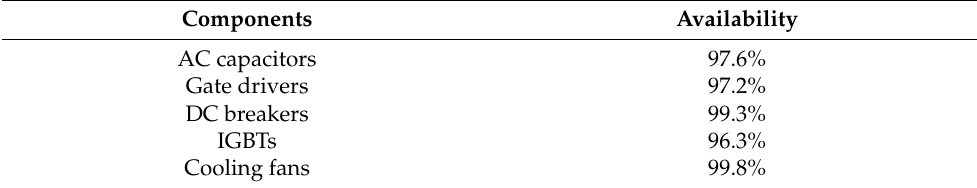
Table 4. Availability for the components of the DC/AC